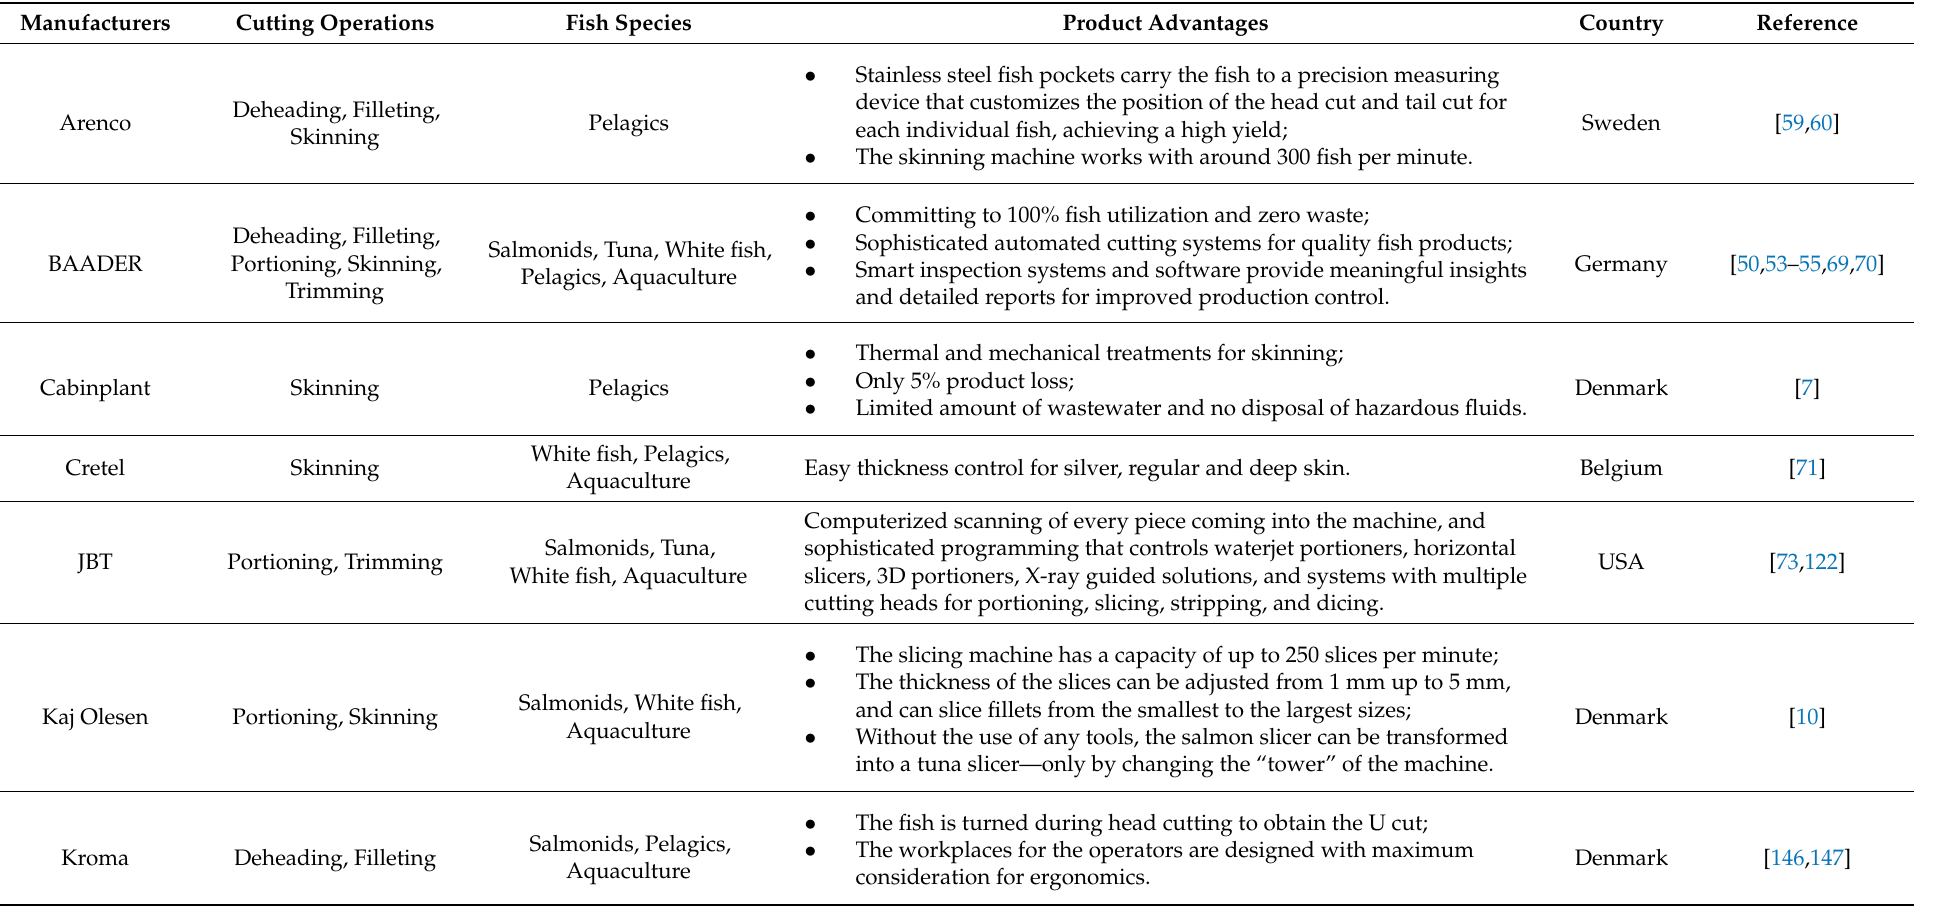
Table 1. Major manufacturers of fish-cutting devices around the